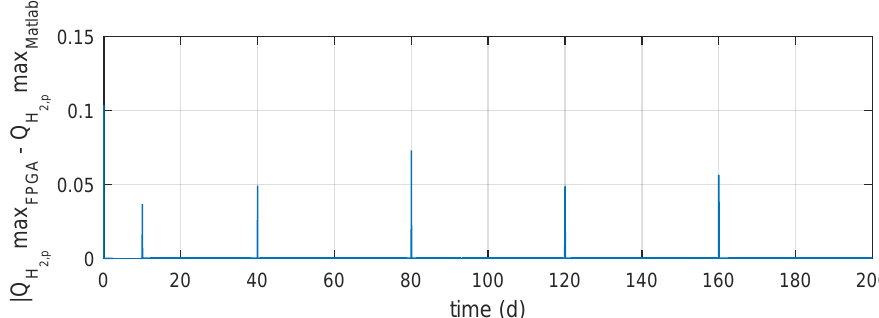
Figure 21. Truncation error in GSS algorithm implementation.